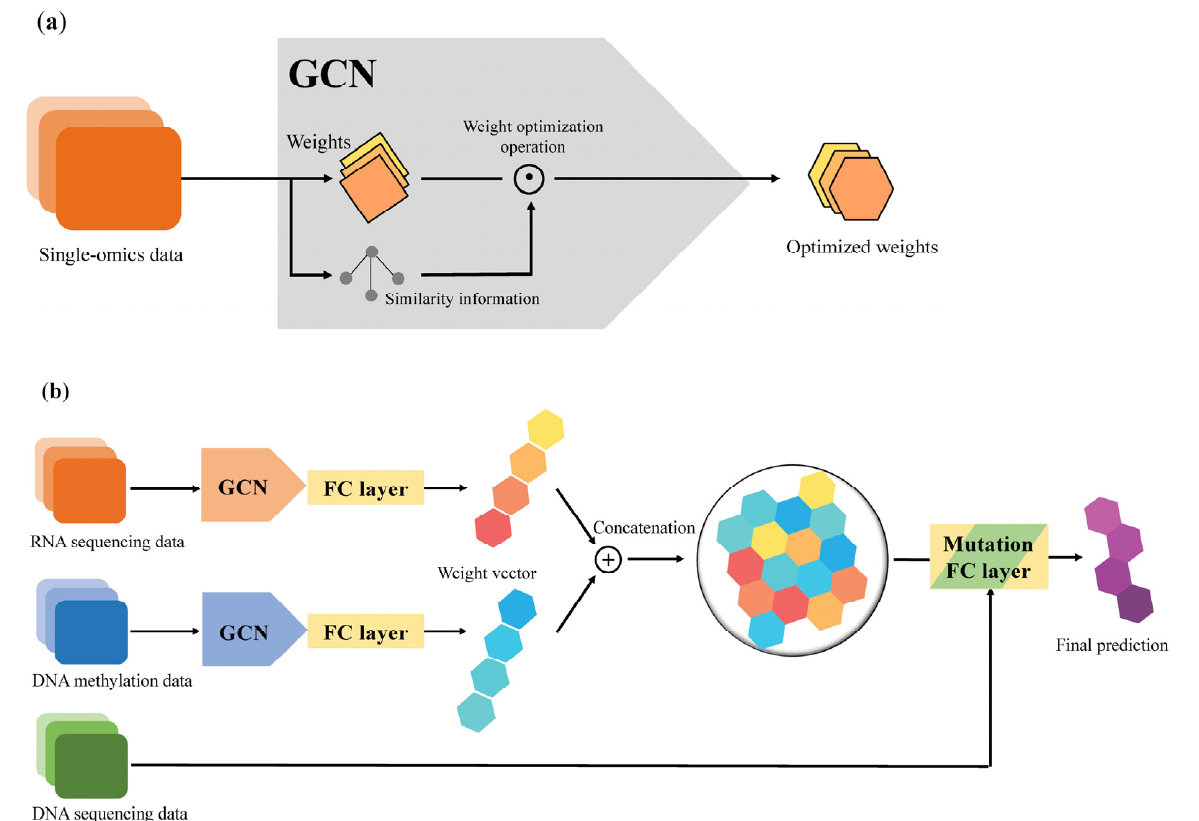
Figure 2. Overview of preprocessing module and graph convolutional network (GCN)-based non- small-cell lung cancer (NSCLC) prediction deep learning model. ( a ) GCN-based preprocessing module for weight optimization. ( b ) GCN-based NSCLC prediction algorithm. DNA sequencing data including targetable gene aberrations are served as discriminating predictors to match the most suitable therapeutic agents in the Mutation FC layer.